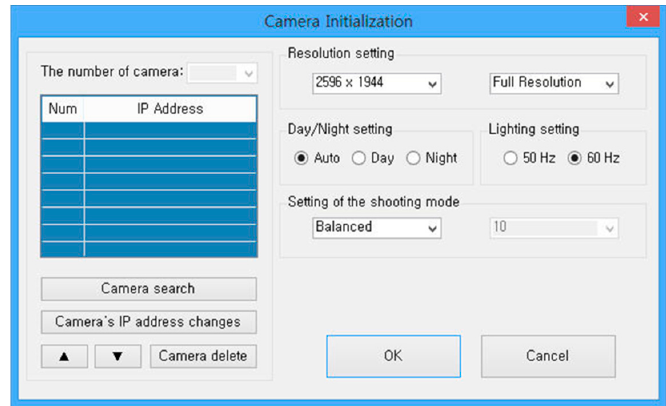
Figure 9. Camera initialization user interface.